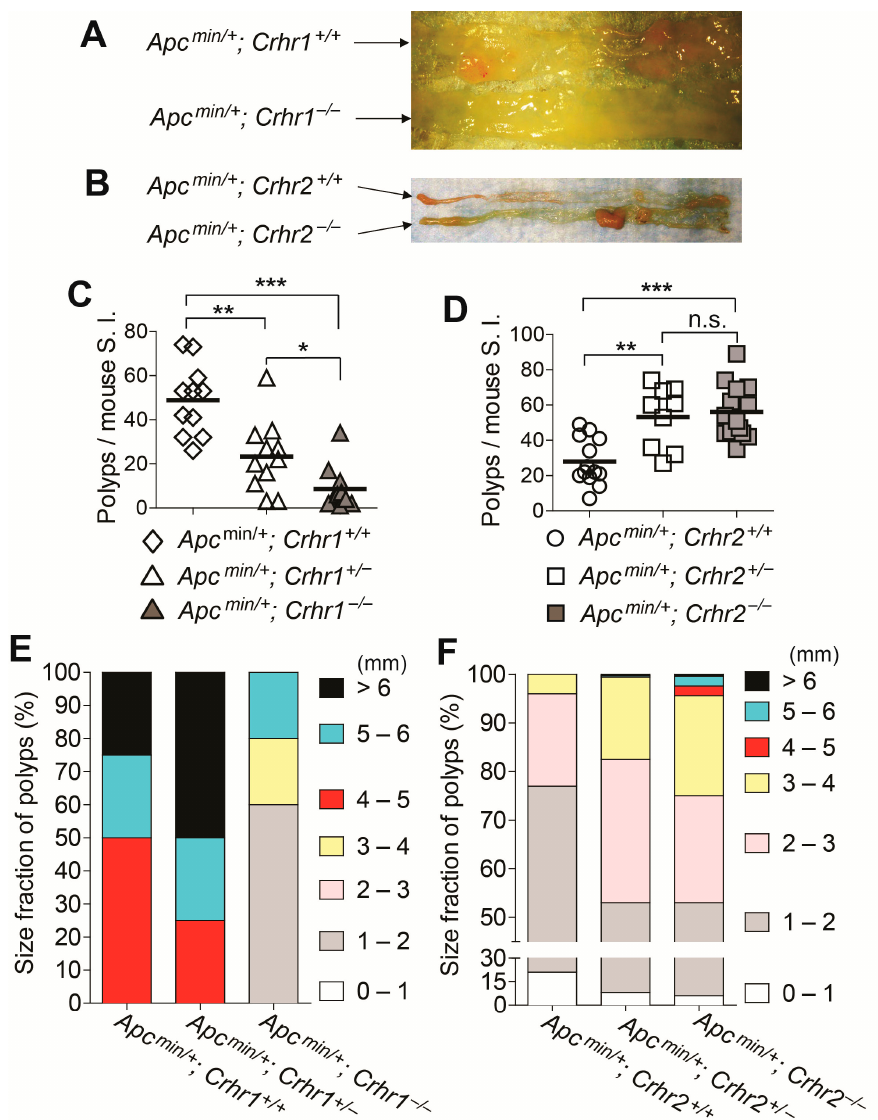
Figure 2. Loss of Crhr1 gene reduces the intestinal tumor development and growth in the Apcmin/+ background, while Crhr2 gene deletion greatly increases the tumorigenesis. ( A , B ) Gross images of the tumors observed in the small intestine of Apcmin/+; Crhr1 − / − mice and littermate Apcmin/+; Crhr1 +/+ mice, and Apcmin/+; Crhr2 − / − mice and littermate Apcmin/+; Crhr2 +/+ mice at the age of 5 months. Presented are the representative images. ( C , D ) At 5 months old, the tissues were harvested. Using stereoscopic microscopy, we counted the number of tumors that were developed throughout the small intestine of each mouse. * p < 0.05, ** p < 0.01, *** p < 0.001 (Mann–Whitney U test). Apcmin/+; Crhr1 +/+ (n = 11), Apcmin/+; Crhr1 +/ − (n = 11), Apcmin/+; Crhr1 − / − (n = 11), Apcmin/+; Crhr2 +/+ (n = 13), Apcmin/+; Crhr2 +/ − (n = 9), Apcmin/+; Crhr2 − / − mice (n = 14). ( E , F ) Tumors observed throughout the small intestine were enumerated to analyze relative proportions (%) of tumor size. Adenomas were classified based on the tumor size: small (<2 mm diameter), medium-sized (2–4 mm), or large (>4 mm). The relative proportions of the size classes were counted and given as a percentage of the total number of